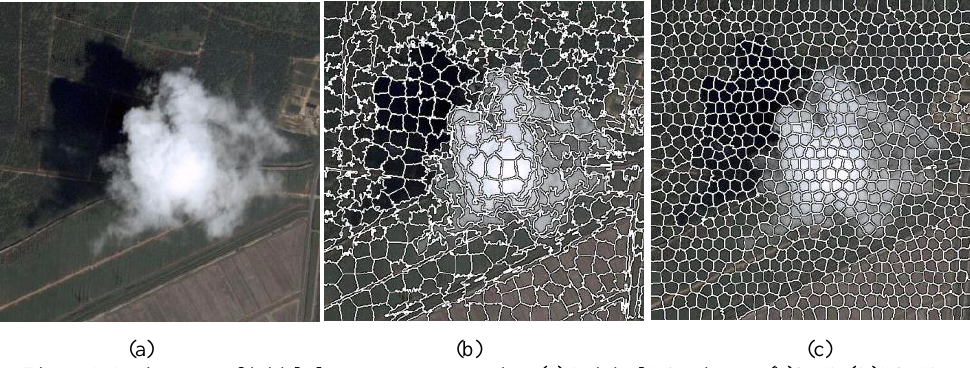
Figure 4. An instance of initial cluster center generation. (a) Original RGB image. (b)SLIC (C)ASLIC